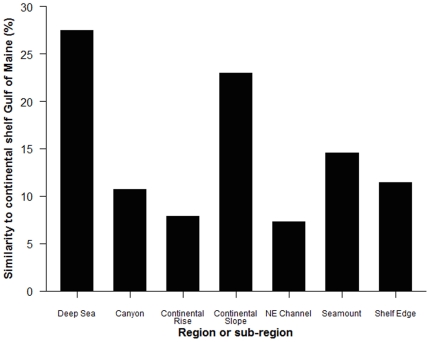
Similarity of species lists.Bray-Curtis similarity (%) of the total deep-sea region species list and the species lists for 6 different sub-regions to the continental shelf Gulf of Maine species list.